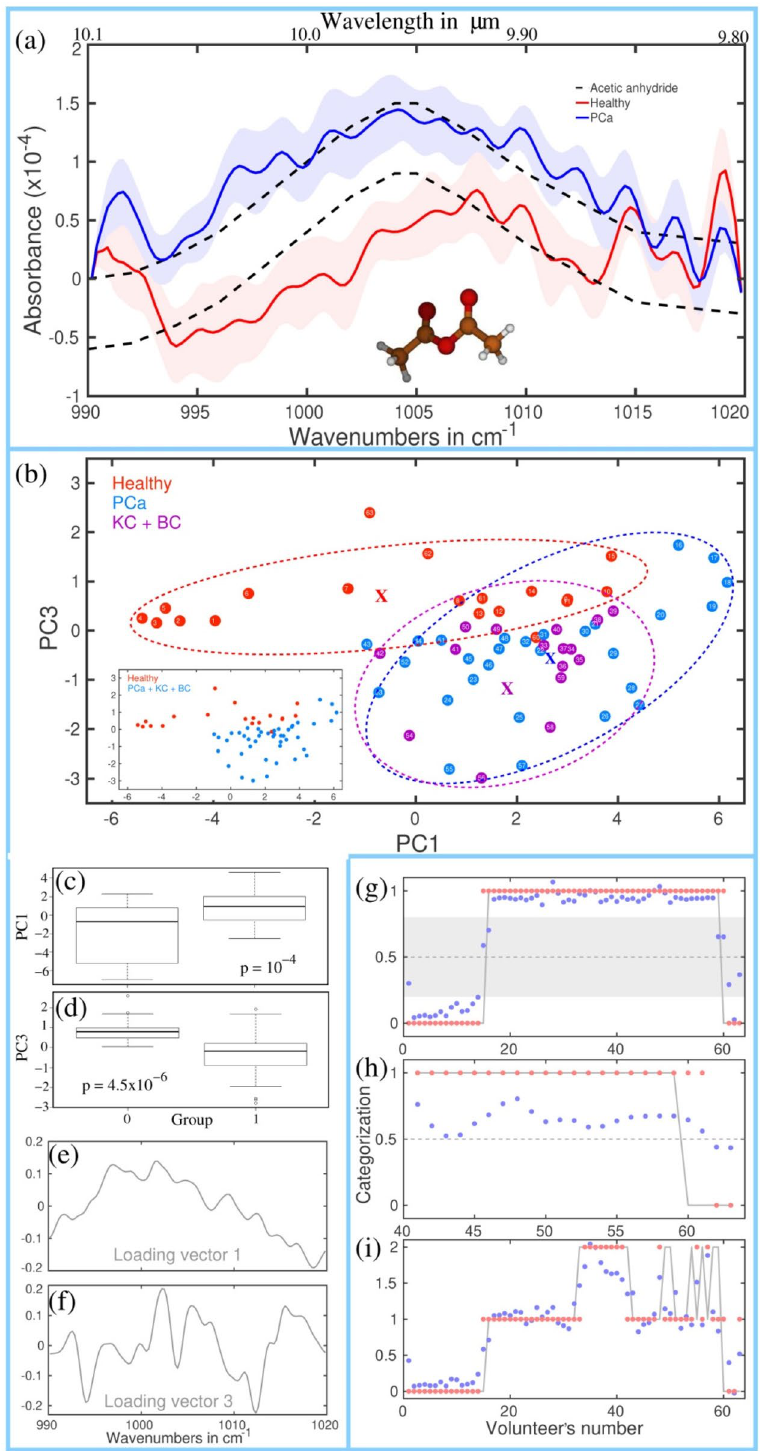
Figure 1. The SR centered at 1005 cm −1 . ( a ) The average absorption spectra for healthy and PCa groups (other groups are shown in Supplementary Fig. S1). Oscillations visible for the range > 1010 cm −1 (especially at 1015, 1019 and 992 cm −1 ) are due to the contribution of CO 221 . Bottom: 3D molecular structure of AA. The corresponding animation: (3D vibration of AA at 1005 cm −1 . avi). White balls: hydrogen atoms, red—oxygen, brown—carbon. Shaded areas: deviations of the absorption in each group. Dashed lines: the absorption spectrum of AA taken from Ref. 21 . ( b – f ) Results of PCA, namely PC3 vs PC1 ( b ), plot boxes ( c , d ) and the corresponding loading vectors ( e , f ). Labels 0 and 1 in ( c , d ) represent healthy and PCa groups, respectively. ( b ) ellipses are shown for visualization, with the corresponding centers marked by “x”. The inlet is visualizes the separation between the healthy and cancer groups. ( g – i ) results of the supervised analyses. Category “0” corresponds to a healthy group, “1”—to a cancer group. ( g ) LOOCV analysis of the healthy and cancer (PCa + BC + KC) groups. Shaded gray zone 0.2–0.8 shows a number of points between the categories 0 and 1. ( h ) blind analysis taken for 4 healthy and 19 cancer patients (PCa + BC + KC). ( i ) 3-category analysis (sevenfold, 10 repetitions). Category “0”corresponds to the healthy group, “1”—to the PCa group and “2”—to the (BC + KC)